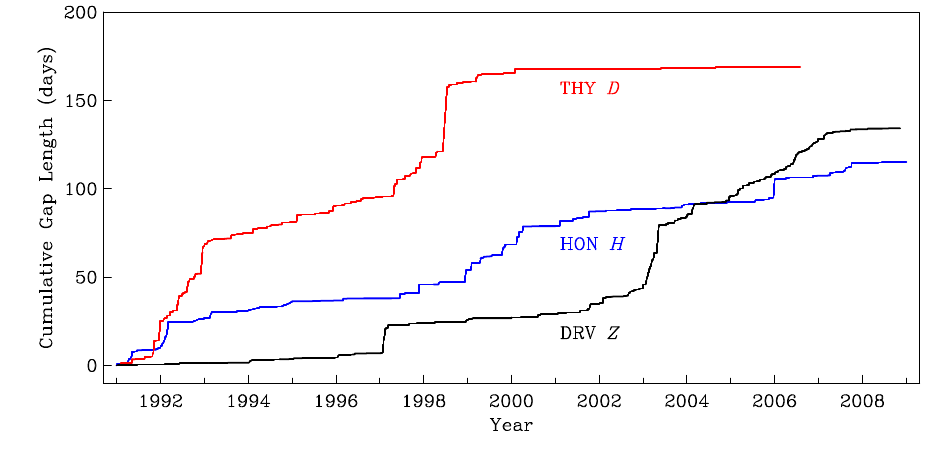
Fig. 1. Cumulative distribution of missing data for (DRV Z , THY D , HON H ) for the years 1991–2008.